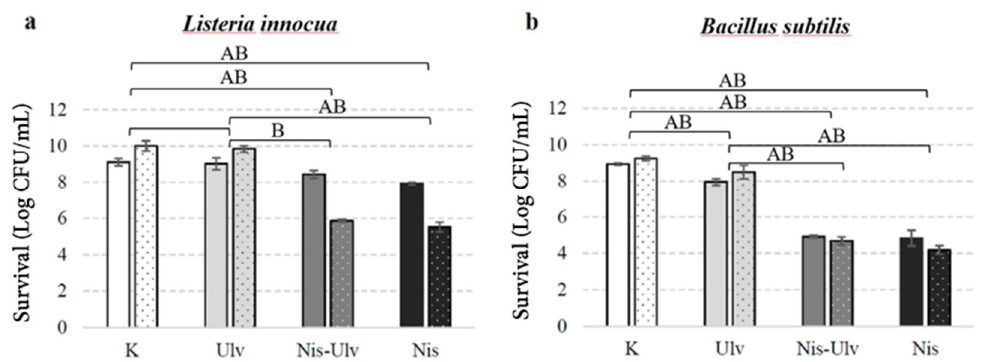
10 of 13 Figure 6. Bacteria sensitivity to nisin-loaded nanoparticles. The inhibitory activity of encapsulated (Nisin-Ulv) and free nisin was demonstrated by measuring growth inhibition zones in agar diffu- sion assay. Free nisin concentration was 0.2 mg/mL; nisin-loaded ulvan particles were prepared using the same concentration of nisin. Table 2. Minimum inhibitory concentration of free and encapsulated nisin.